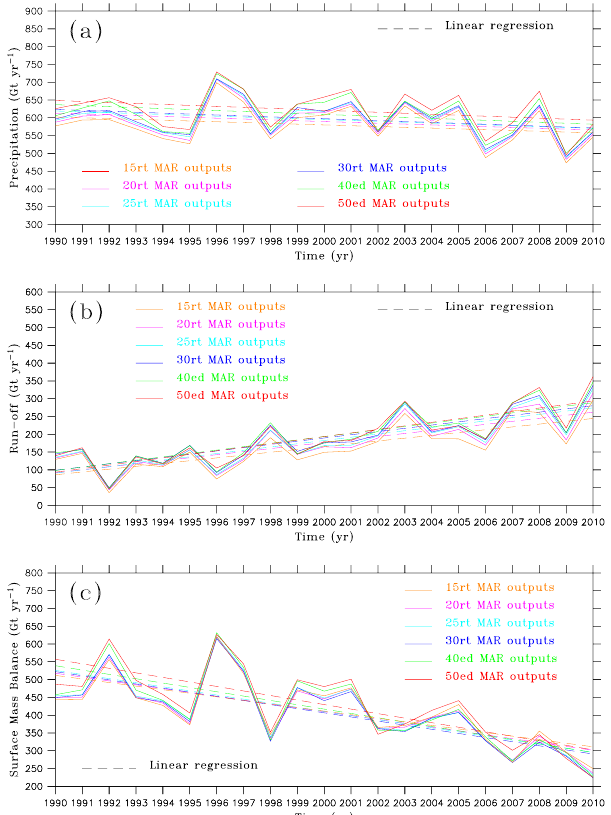
Fig. 5. (a) Annual precipitation (Gtyr − 1 ) on the GrIS simulated by the MAR model at 15–50km resolution (in solid lines), over the ice sheet mask common to all the spatial resolutions. The 20–50km resolution outputs have been interpolated onto the 15km MAR grid. The linear regressions throughout the 1990–2010 period are drawn in dashed lines. (b) The same as (a) , but for the annual run-off of meltwater (Gtyr − 1 ) from the GrIS. (c) The same as (a) , but for the annual GrIS SMB (Gtyr − 1